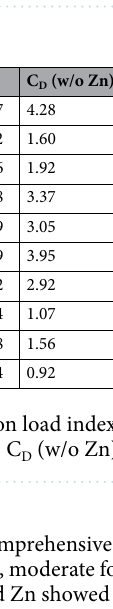
Figure 5. Zn ( left ) and Al ( right ) concentrations (mg/kg soil, dry weight) in the urban sinkholes in the study in Cancun. Ph -Phase (1 to 5) TE— Total extraction.